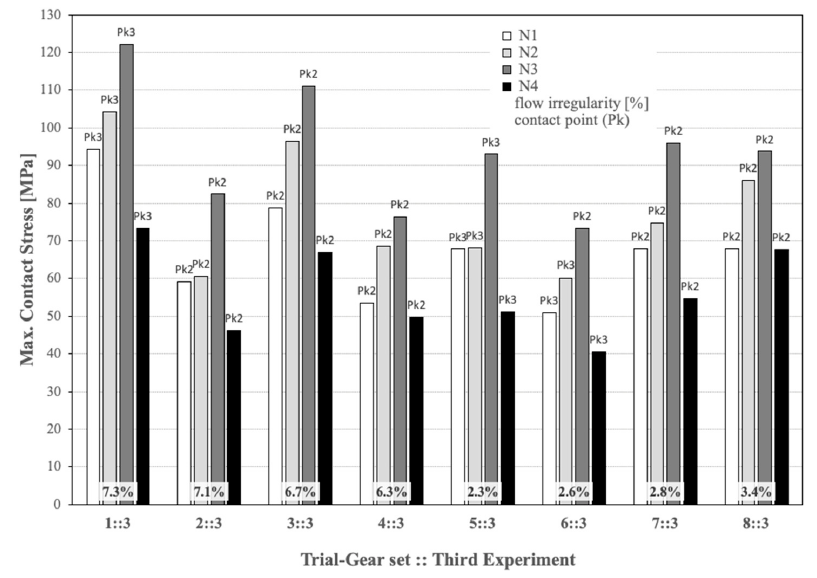
Figure 12. Results of FEM maximum contact stress [MPa], GeroLAB flow irregularity [%], and contact point (Pk) of maximum contact stress in each gear set with 4 FEM conditions noise factors for the third Taguchi experiment (see Table